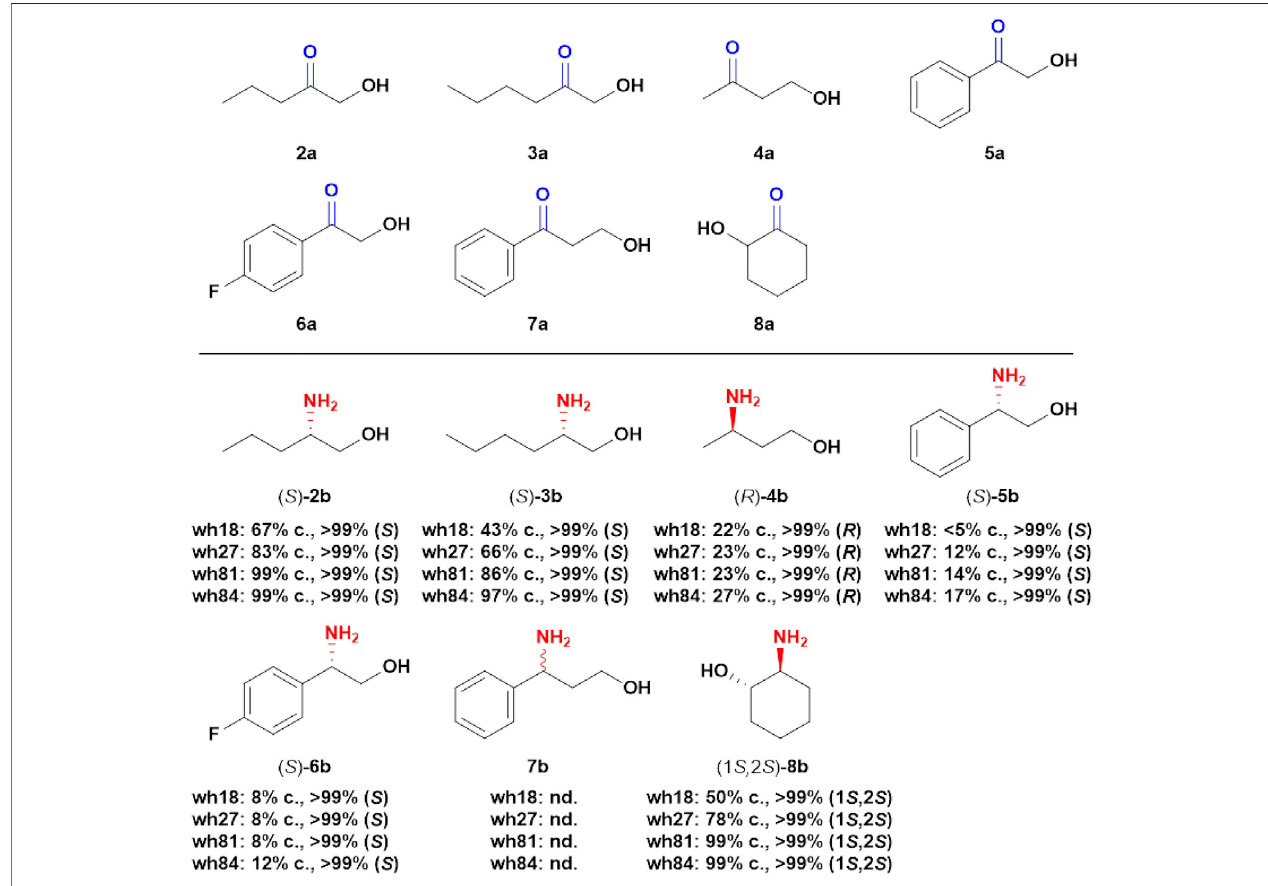
FIGURE 6 | Asymmetric transformations of hydroxy ketones. Reaction system: 0.1 g/ml wet cell, 1 M NH 4 Cl/NH 3 · H 2 O buffer (pH 8.5), 1 mM NAD + , 100 mM glucose, 2 mg/ml GDH CFE, 6 U/ml DNase I, 1 mg/ml lysozyme, and 2a-8a (5 mM) were mixed in 2 ml Eppendorf tubes. The reaction was performed at 30 ° C, 1,000 rpm for 24 h in a thermostatic metal bath. c, conversion; nd, not detectable.